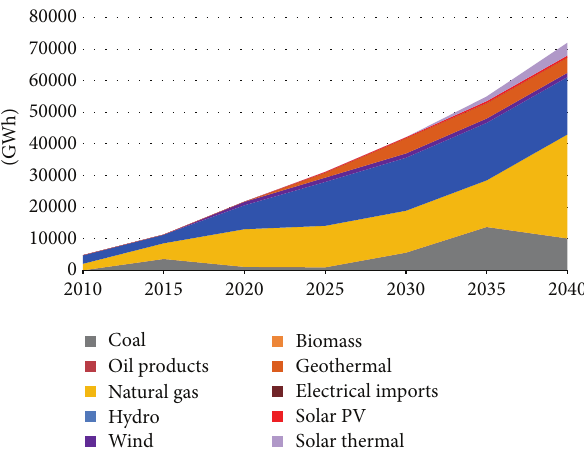
Figure 4: Electricity production by energy source, RE